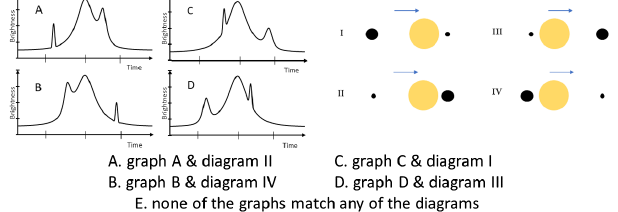
FIG. 6. FIQ on detecting exoplanets via gravitational micro-